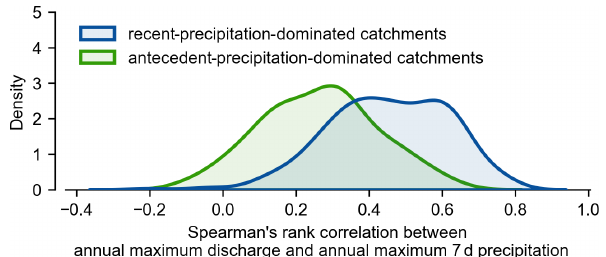
Figure B2. The distribution of Spearman’s correlations between an- nual maximum discharge and annual maximum 7d precipitation for two groups of catchments (blue, recent-precipitation-dominated catchments; green, antecedent-precipitation-dominated catchments, based on Fig. 6a). It shows that the catchments where floods are dominated by recent precipitation tend to have higher correlations than antecedent-precipitation-dominated catchments, which implies that the former might be more susceptible to changes in extreme 7d